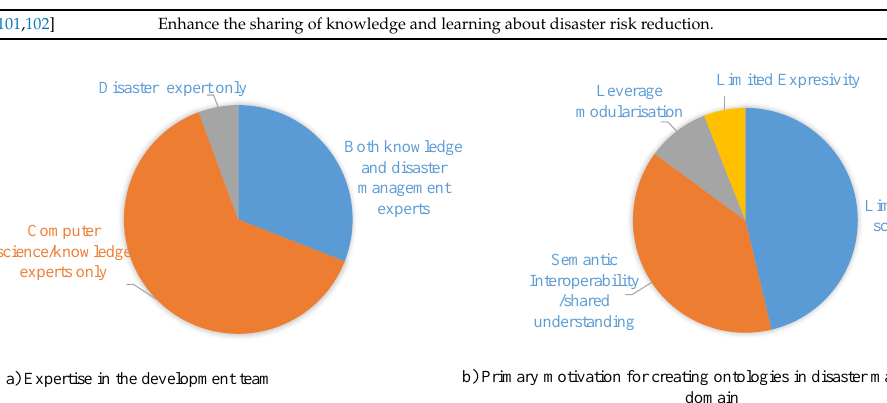
Figure 2. Summary of Expertise of Development Team and Motivation for Ontology